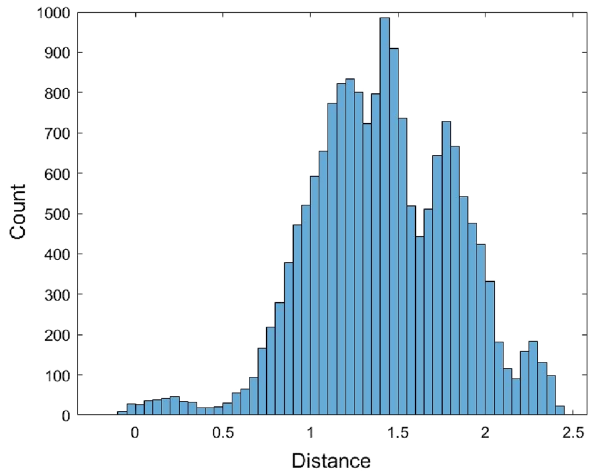
Figure 10. The histogram of 17,519 data generated from the fitted kernel density estimation method of the Kimura model distance data.